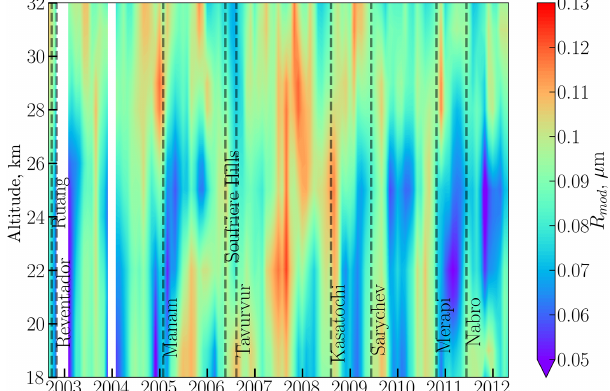
Figure 11. Deseasonalized time series (anomalies) of R mod re-